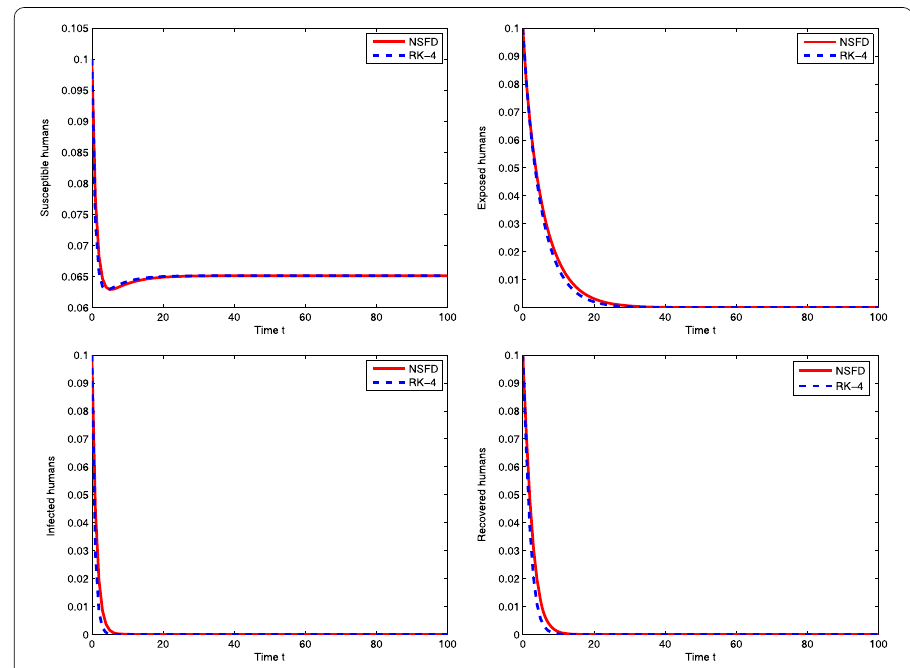
Figure 2 Comparison of solutions obtained by NSFD and RK4 numerical schemes for F 0 with an initial condition ( S (0), E (0), I (0), R (0)) = (0.1,0.1,0.1,0.1) and step size h = 1.0. Both the schemes converge to the true steady state of F 0 with R 0 = 0.2167 < 1